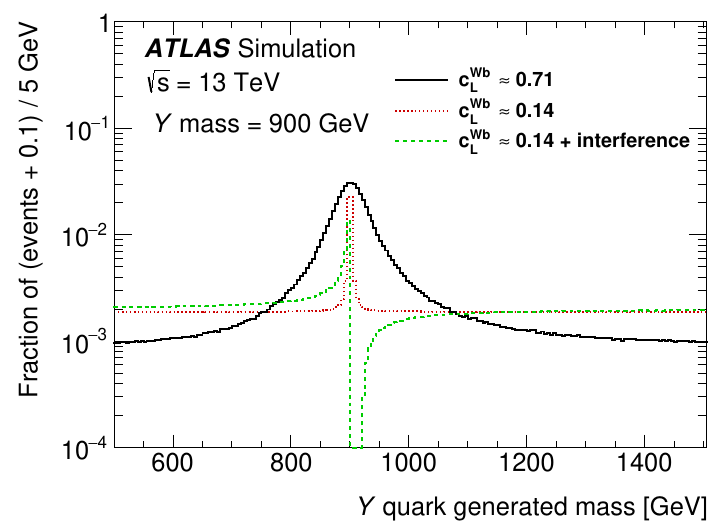
Figure 3. The generated mass distributions at particle level for a Y quark with a mass of 900 GeV, for a coupling strength of c 0 = (cid:20) T 0 : 5 and c Wb 1 = p 2 ( c Wb = 0 , solid line) and of c 0 = c Wb = L (cid:25) R L (cid:25) 0 : 14 (dotted line) as de(cid:12)ned in ref. [95]. The distribution for a right-handed only and left-handed only Y quark (solid line) is the same. The dashed line shows the generated vector-like quark mass distribution at particle level of a left-handed Y signal with a mass of 900 GeV, coupling strength of c Wb = 0 : 14 and interference e(cid:11)ects with the SM included. The interference e(cid:11)ects lead to negative L entries in some bins of the distribution. For better visualisation of the tail distribution including